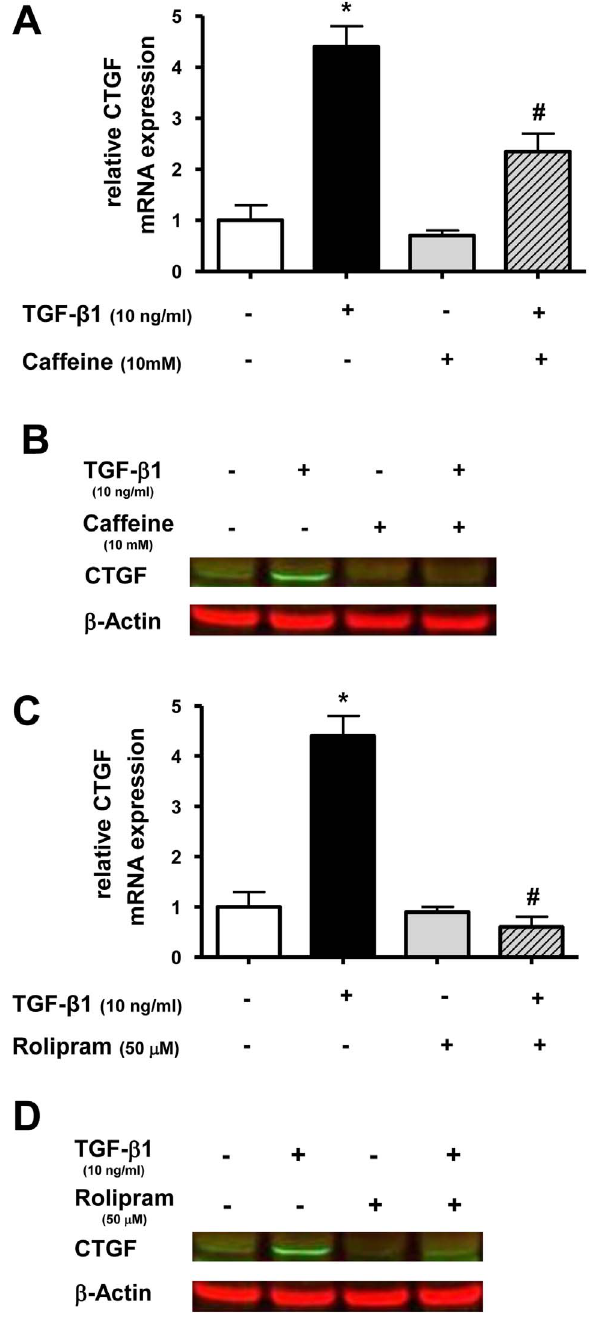
Figure 2. Caffeine and rolipram inhibit TGF- b 1 induced CTGF expression in lung epithelial cells. A549 cells were incubated with TGF- b 1 (10 ng/ml) and with or without caffeine (10 mM) or rolipram (50 m M). Real-time PCR of CTGF mRNA was performed after 12h (A + C) and Western blot analysis after 24 h (B + D). Relative mRNA levels of CTGF were calculated by normalizing signals to detected GAPDH mRNA. Differences compared to untreated cells were calculated (A + C). Means 6 SD of at least n=3 independent experiments are shown. In B + D representative immunoblots of at least three independent experi- ments are shown. * p , 0.05 compared to control cells, # p , 0.05 compared to cells treated with TGF- b 1.